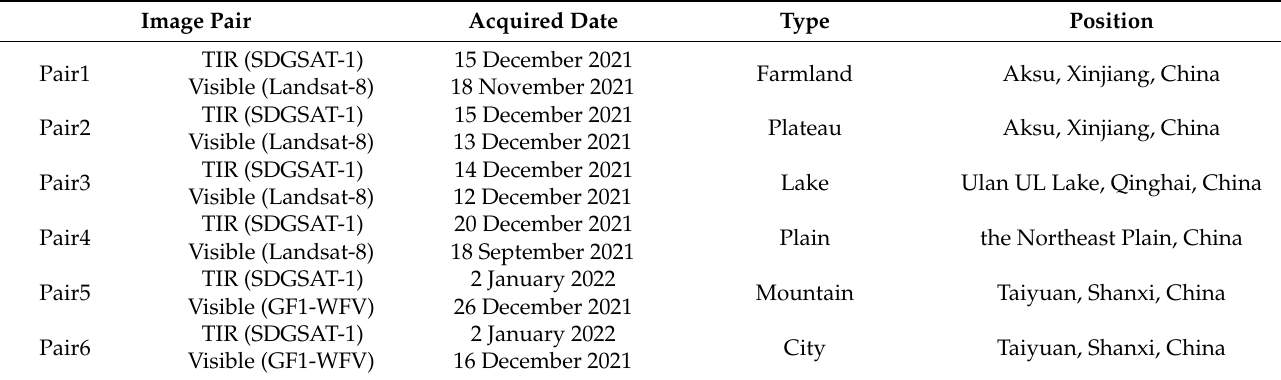
Figure 4. Six test image pairs. The TIR images (SDGSAT-1, B1 band) are in the first line and the visible images (Landsat8, true color synthesis) are in the second line. In order to display clearly, the TIR images have been processed by homomorphic filtering. Table 2. The detailed information about the test image pairs.